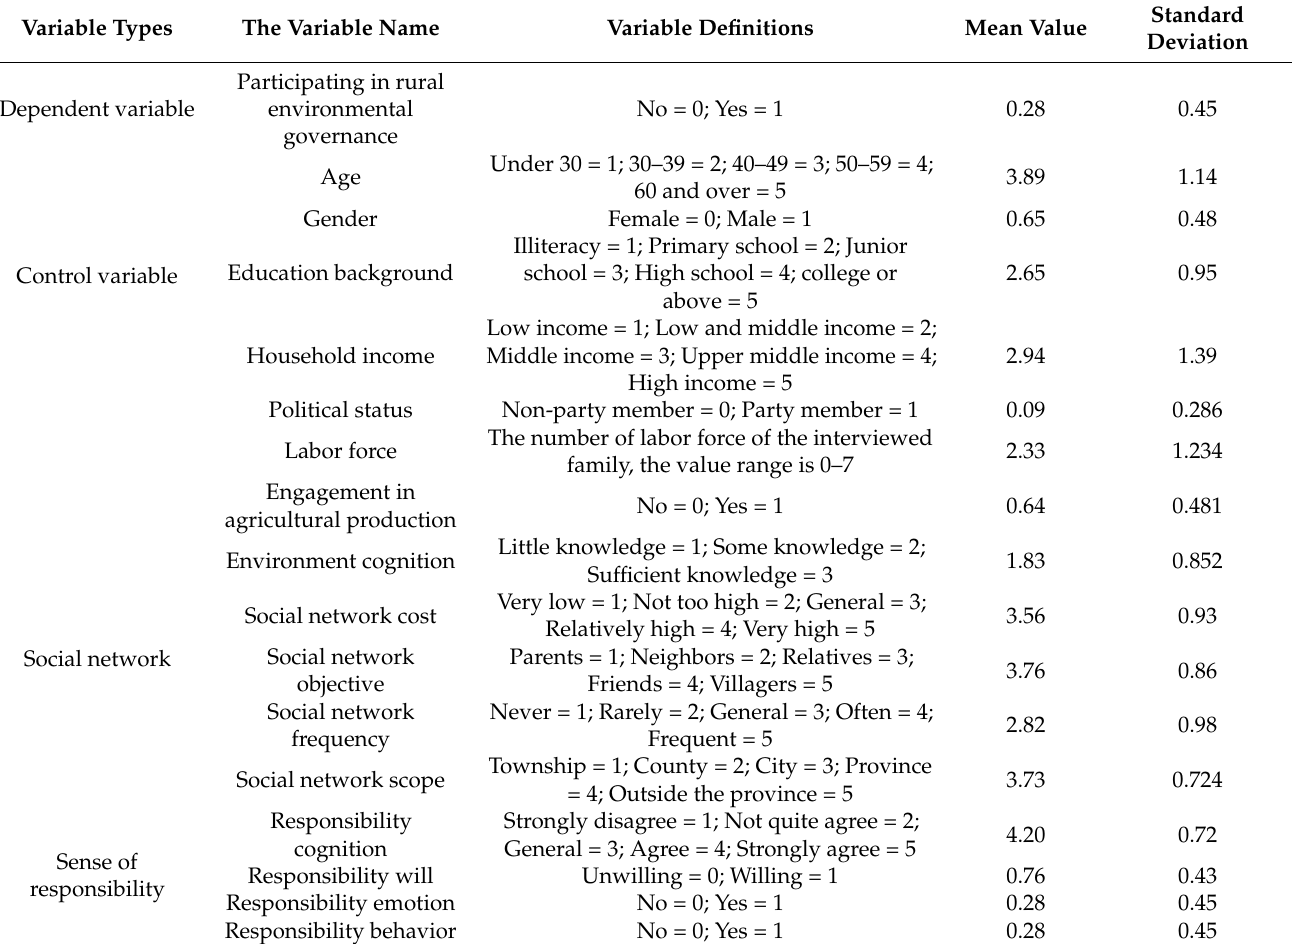
Table 3. Variable definition and